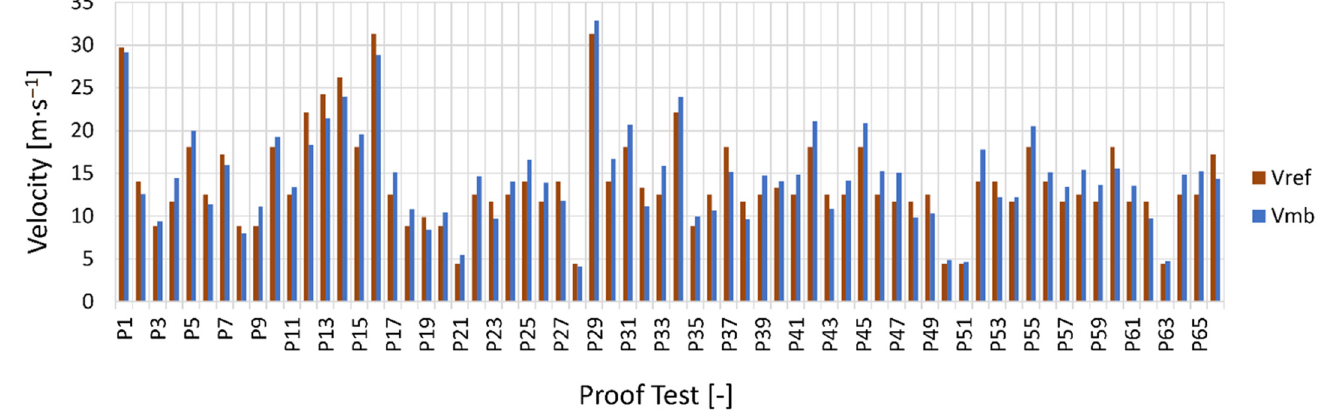
Figure 12. Comparison between maximum cornering velocities predicted with the present ML-KNN method and the calculated multibody model of PTW vehicle.